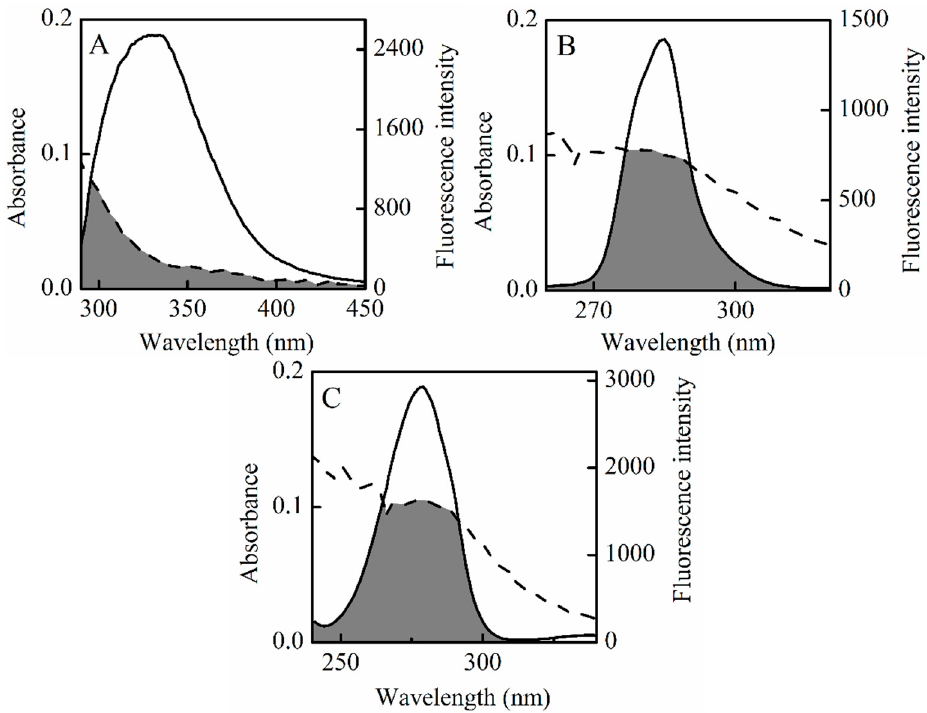
Figure 7. Overlap of the UV absorption spectra of SSC and the fluorescence emission spectra. Dotted line is the UV absorption spectra of 3 mM SSC. ( A – C ) is the fluorescence emission spectra of C HSA = 2 μ M, ∆λ = 15 nm or ∆λ = 60 nm, respectively.